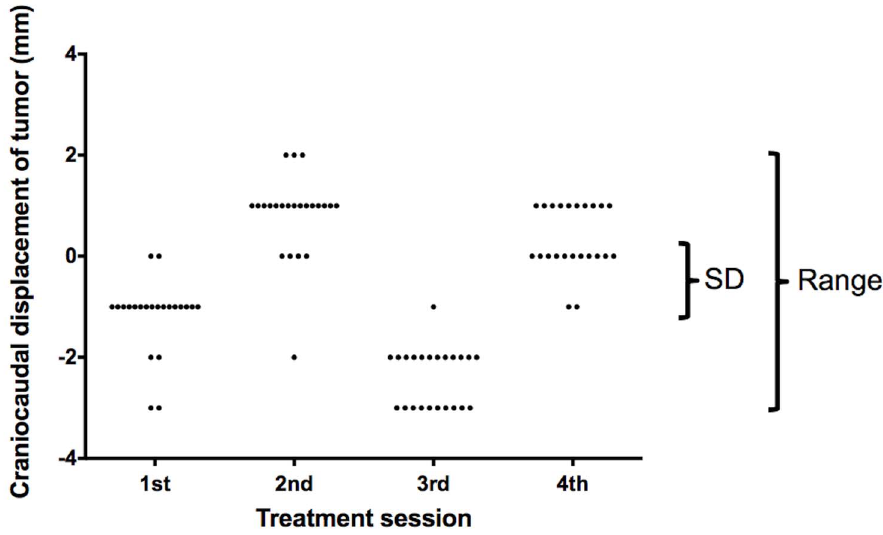
Figure 2. Variability assessment for each patient. Variability was assessed by determining the standard deviation (SD) and range of the tumor position during all sessions.